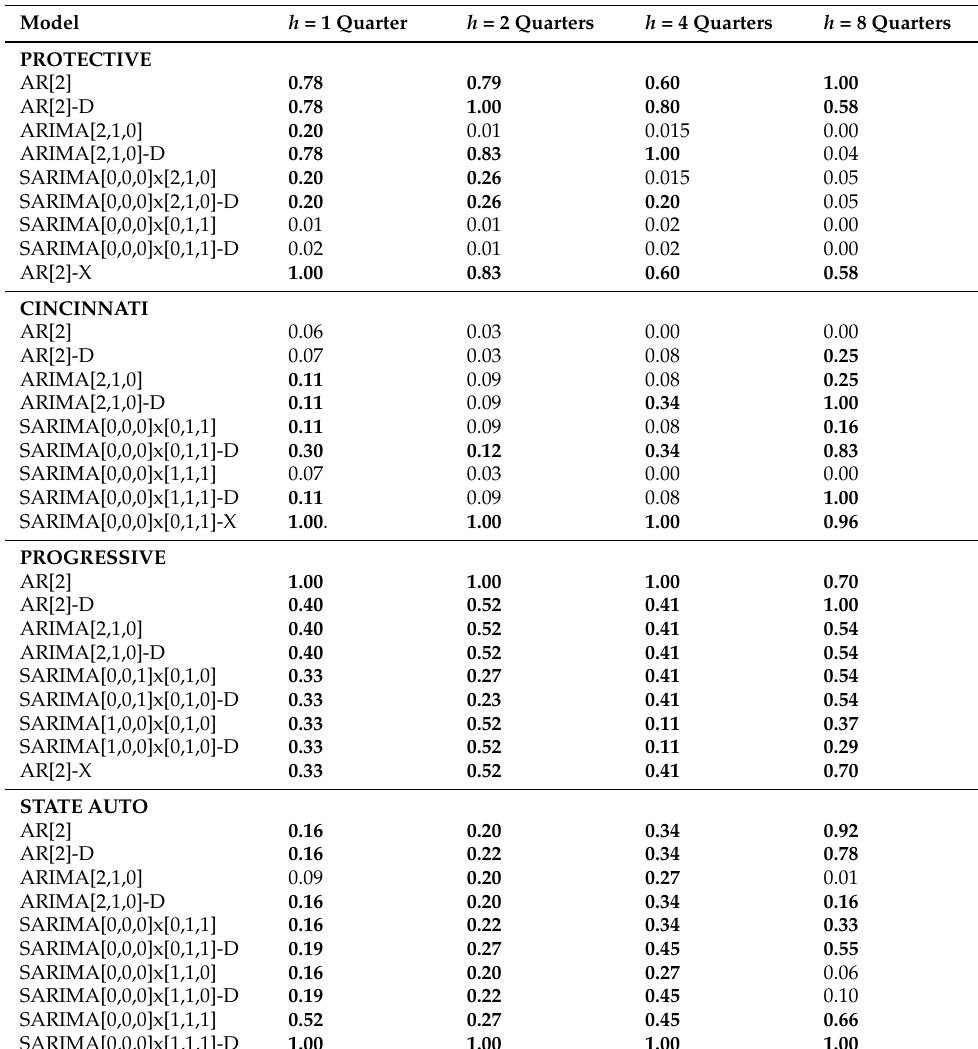
Table 5. MCS p -values with respect to the MSE values of forecasts of underwriting ratios based on 1000 stationary bootstrap resamples for the companies, Protective, Cincinnati, Progressive, and State Auto, and for each of the forecasting horizons h = 1,2,4 and 8 quarters. Forecasts in the 90% MCS in bold